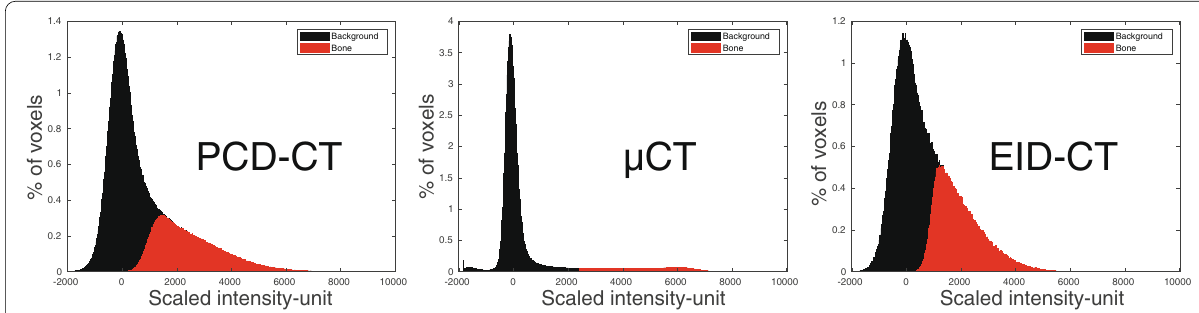
Fig. 4 Stacked histogram of scaled intensity for the voxels segmented as bone and background for one of the bone specimens. For multislice computed tomography using photon-counting detectors (PCD-CT) and multislice computed tomography using energy-integrating detectors (EID-CT) data, the segmentation was achieved by the automated region growing algorithm, while the micro-CT data was segmented using Otsu thresholding. For the PCD-CT, the combination of a field of view of 51 mm and a matrix of 1,024 setting with the same CTDIvol as the PCD-CT was used. Micro-CT Micro-computed